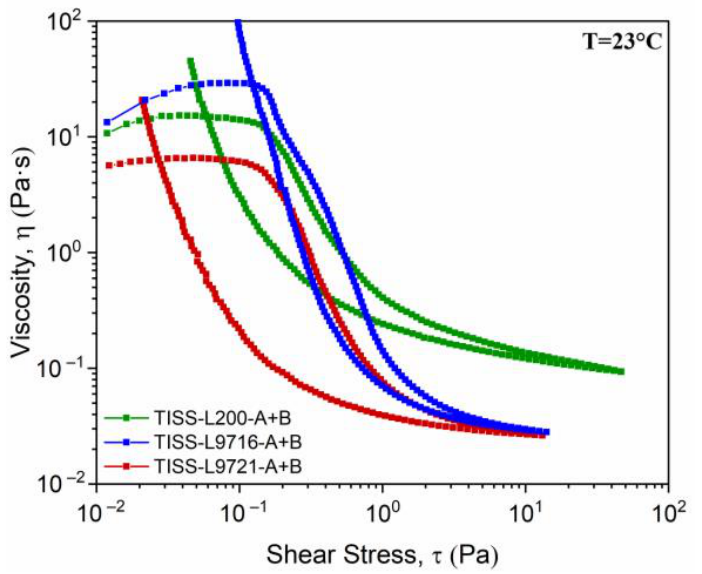
Figure 5. Viscosity curves of TISS paints, prepared with binders L200, L9716 and L9721. All liquid paints were measured after the addition of catalyst Desmodur N75.